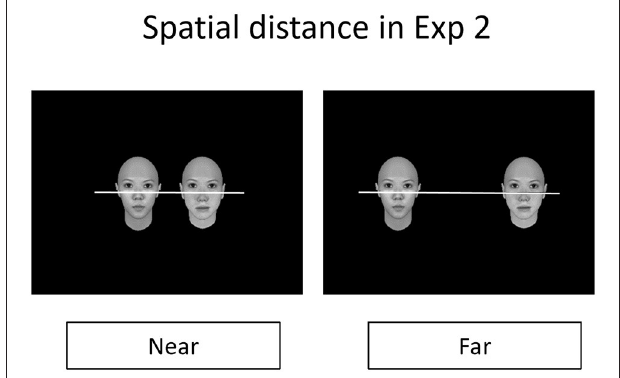
FIGURE 6 | The figure illustrates an example for the display of the stimuli in Experiment 2, where we manipulated the spatial distance in terms of the visual arc between the pair of faces, ∼ 5 ◦ for the near condition and ∼ 10 ◦ for the far